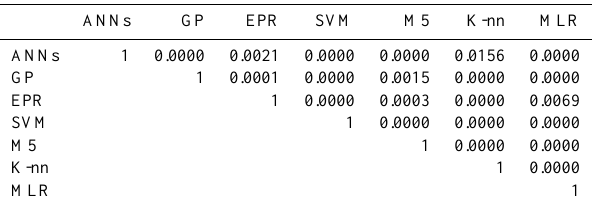
Table 11. The p -values of the two samples K-S test on the model residuals (peat